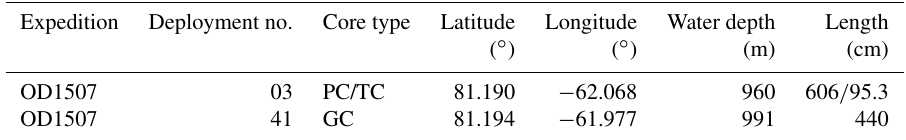
Table 1. Metadata of sediment cores used with the OD1507-03TC-41GC-03PC splice (Reilly et al.,